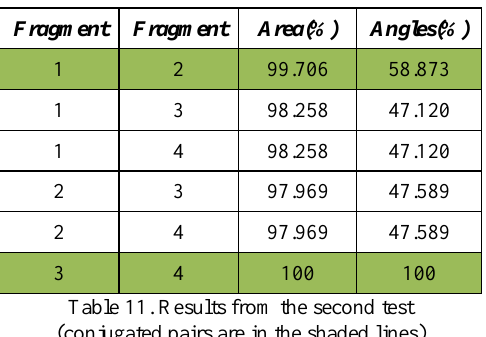
Table 11. Results from the second